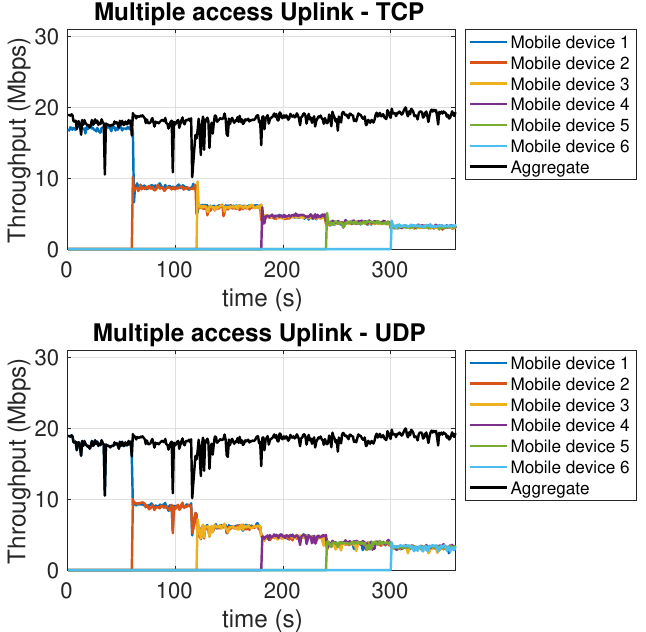
Figure 8. Multiple access uplink with TCP (top chart) and UDP (bottom